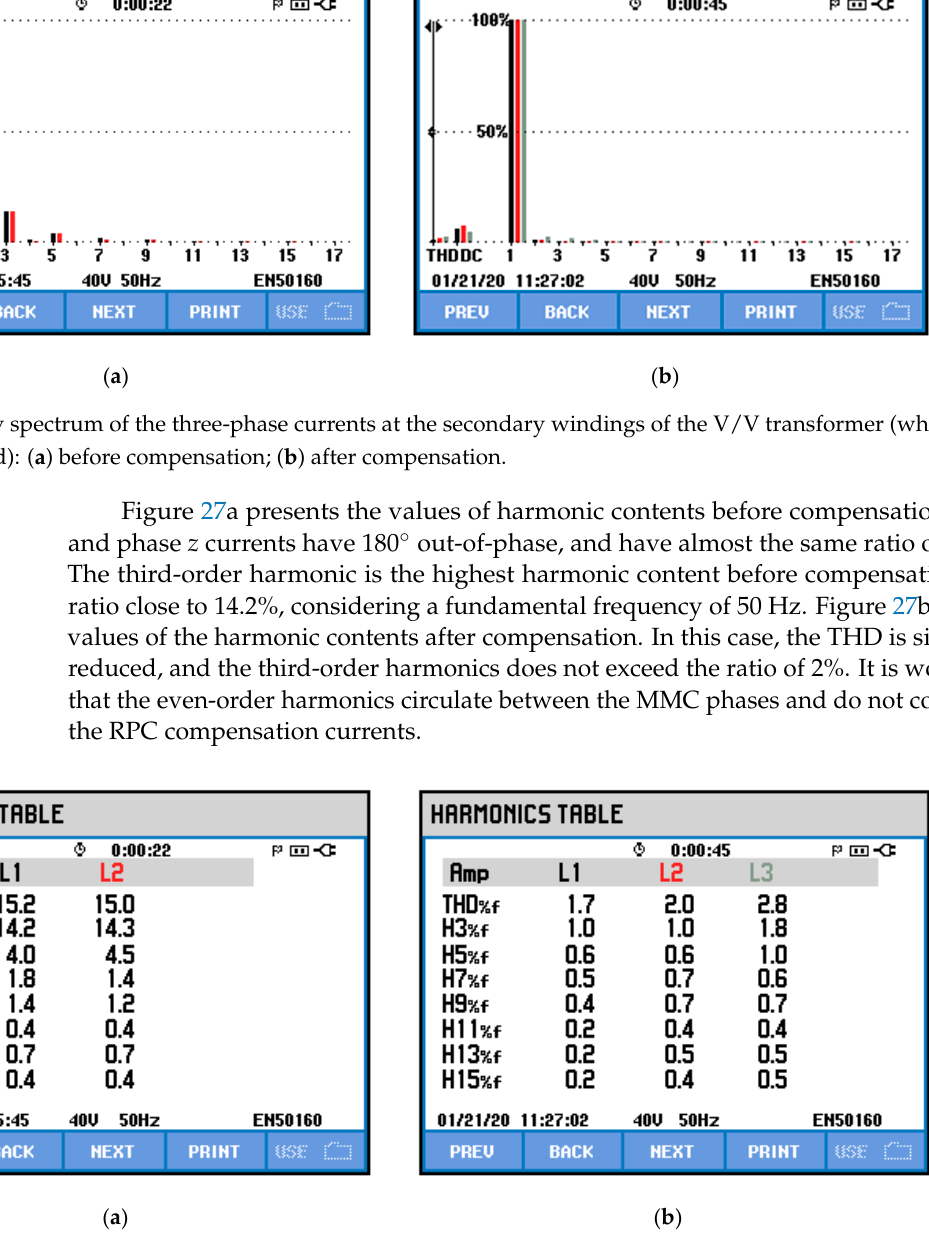
Figure 27. Harmonic contents value of the three-phase currents at the secondary windings of the V/V transformer (when one load section is loaded): ( a ) before compensation; ( b ) after compensation.